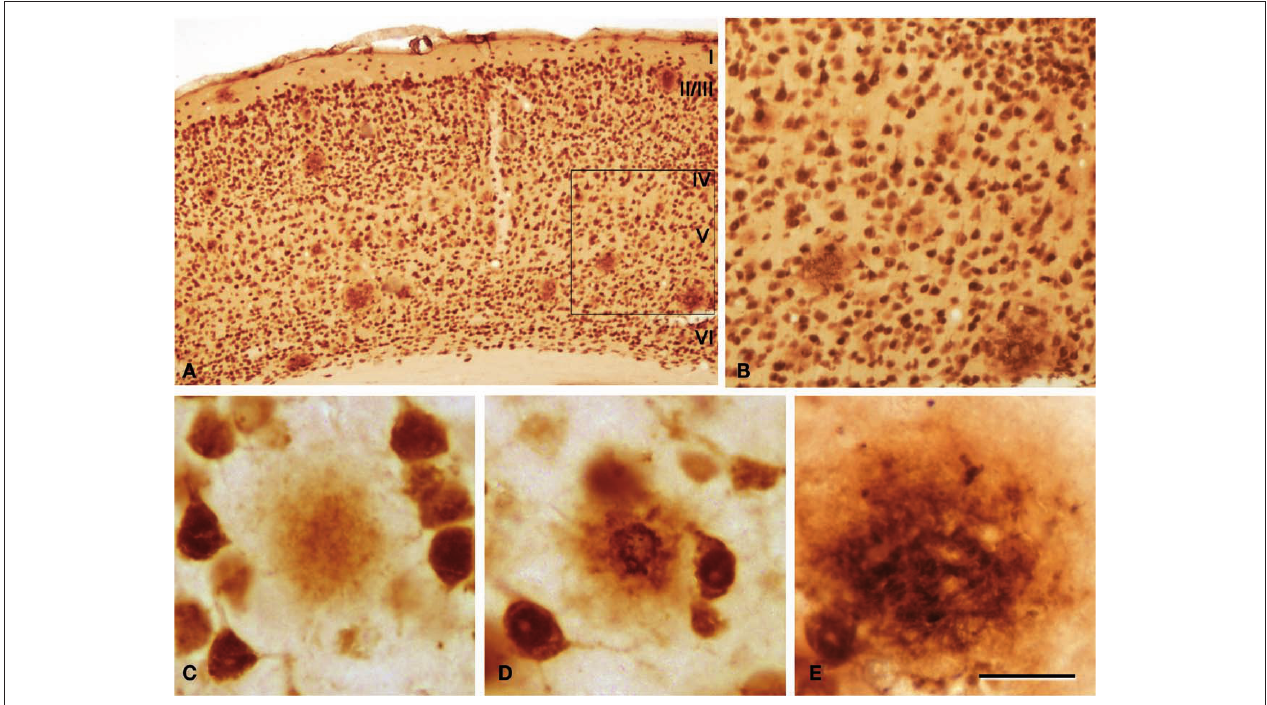
boxed area in (A) . (C–E) Examples of diffuse, cored neuritic and non-cored neuritic plaques, respectively. Scale bar, 200 µm in (A) ; 100 µm in (B) ; 50 µm in (C–E)